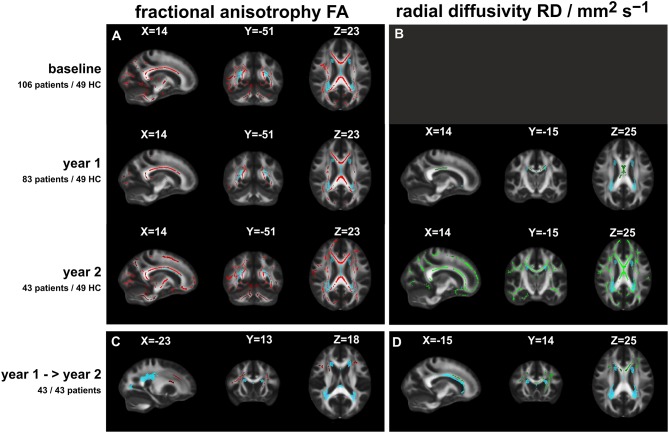
Significant FA or RD differences between patients and healthy controls (TBSS analyses: t-tests including age and sex as nuisance variables; with correction for multiple comparisons by TFCE cluster enhancement at a significance threshold of p < 0.01). (A) (Left column): fractional anisotropy FA (red overlay) at three time points; (B) (right column): radial diffusivity RD (green overlay) at FU1 and FU2 (no significant differences at baseline). Lowest row: comparison of FA (C) and RD (D) between patients at year 1 and at year 2. The light blue overlays depict the lesion distribution (threshold: 0.1) at the specific time points; X, Y, Z: MNI coordinates of slice positions.